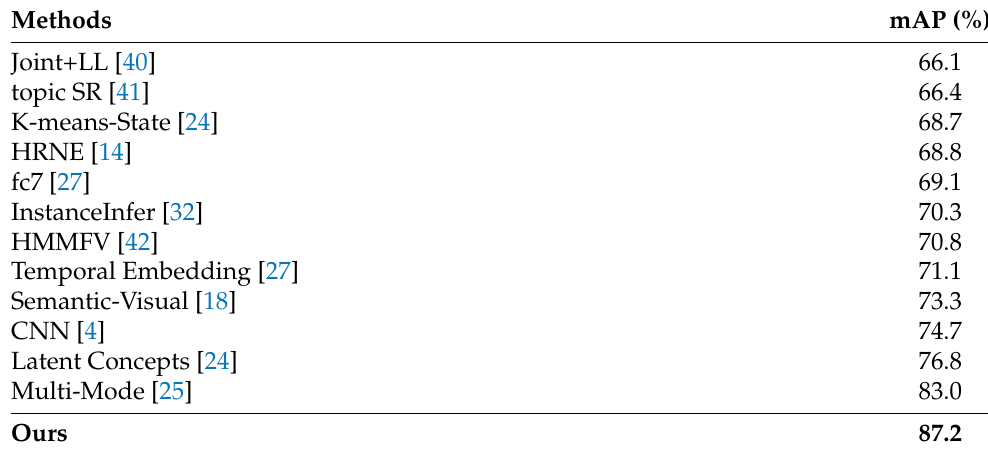
Table 3. Performance comparisons of the proposed method with other event detection methods on the MED11